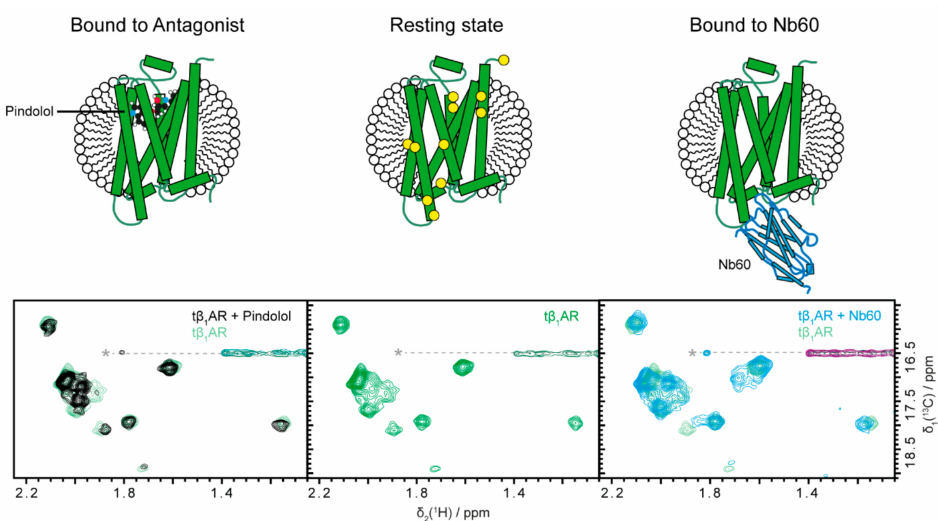
Figure 2. Stabilization of inactive states by drugs and Nb60. The inactive states of t β 1 AR-TS can be stabilized by addition of the small molecule antagonist pindolol (ball and stick model, left) to the resting receptor (middle) or by addition of Nb60 (cyan, right). Only minor changes in chemical shift arise, indicating that the equilibrium of the resting receptor already strongly prefers the inactive state. Yellow circles indicate the position of methionine residues in the receptor. The dashed line with the asterisk denotes an artefact from an intense detergent signal outside of the shown spectral region. Methyl spectra were acquired at 25 ◦ C on a 50 µ M Met ε -[ 13 CH 3 ] labelled t β 1 AR-TS sample in 20 mM HEPES (pH 7.5), 300 mM NaCl and 0.2% n -decyl- β - d -maltopyranoside using the XL-ALSOFAST [ 13 C, 1 H]-HMQC experiment on a 900 MHz Bruker Avance-III HD spectrometer. The sample with pindolol contained 100 µ M pindolol, 1 mM isoprenaline, 4 mM ascorbate and a stochiometric equivalent of mini-G s to the receptor. The sample with Nb60 contained 1 mM isoprenaline, 4 mM ascorbate and 2 stochiometric equivalents of